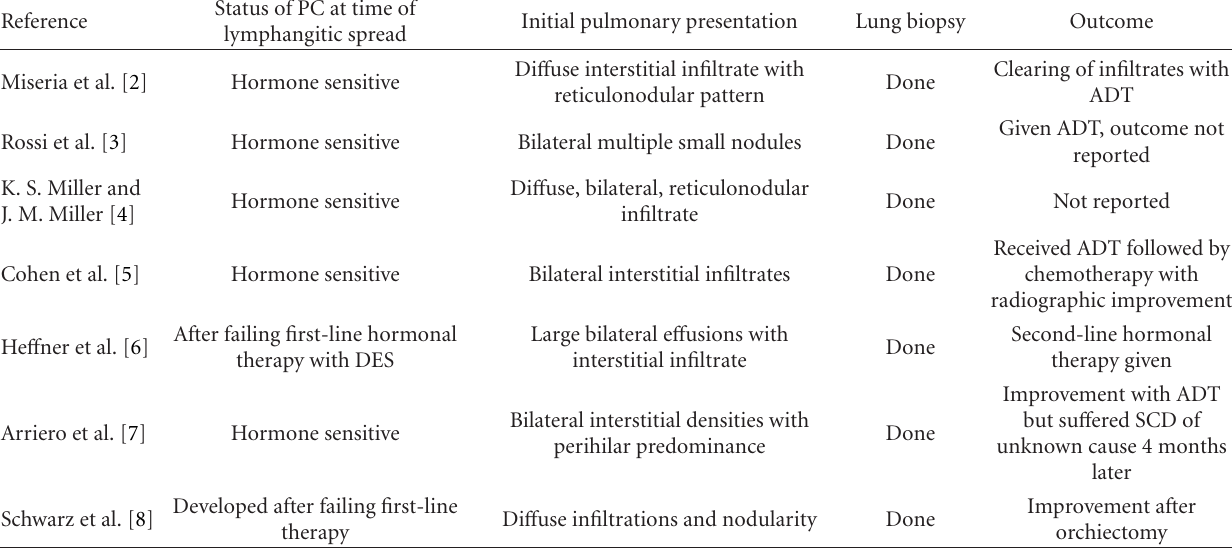
Table 1: Previously reported cases of lymphangitic pulmonary metastasis of prostate